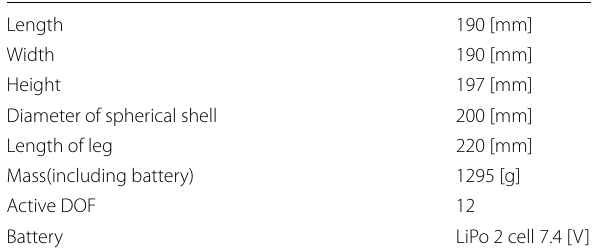
Table 1 QRoSS V Specifications